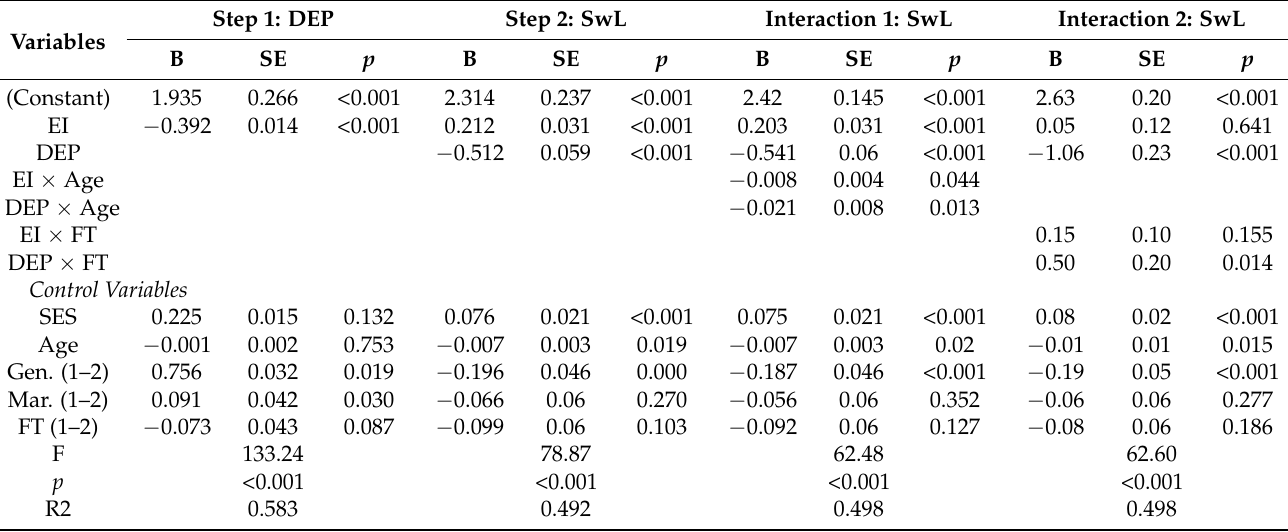
Table 4. Main and interaction effects on DEP and SwL.